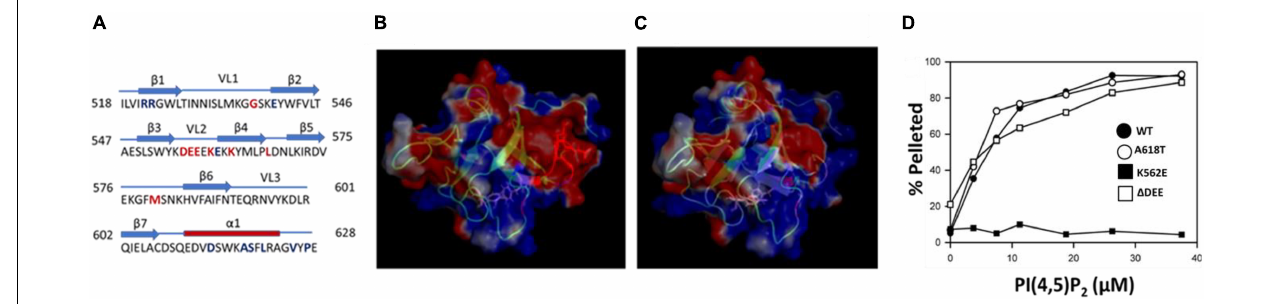
FIGURE 1 | The (cid:49) DEE mutation does not affect binding of the DNM2 PHD to PIP 2 . (A) Location of the 555 DEE 557 motif within VL2 of the PHD. Residues mutated in CMT and CNM are in red and blue, respectively. (B) Electrostatic potential surface of the DNM2 PHD. Red indicates negative potential; blue indicates positive potential. Residues 555 DEE 557 are shown in red (modified from DNM2 PHD, PDB ID:2ys1 (Li et al., 2008). (C) Electrostatic potential surface of the DNM2 (cid:49) DEE PHD. (D) Binding of isolated WT and mutant DNM2 PHDs (5 µ M each) to PIP 2 -containing vesicles. A co-sedimentation assay (Lee and Lemmon) was used to measure binding of purified GST-PHDs to small unilamellar vesicles composed of brominated-PC:PIP 2 at a molar ratio of 97:3.